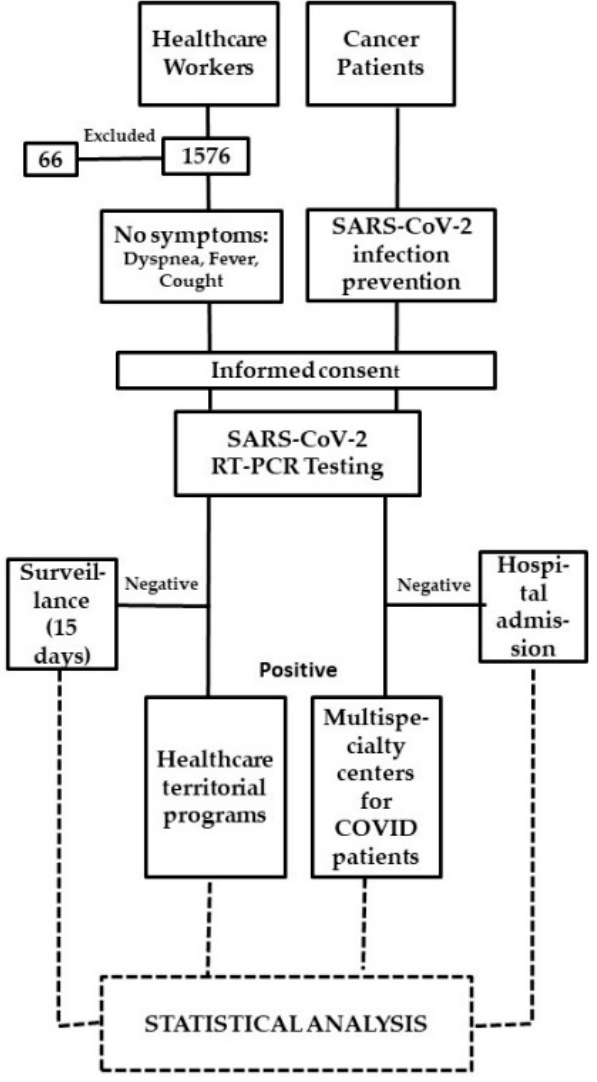
Figure 1. Study flow